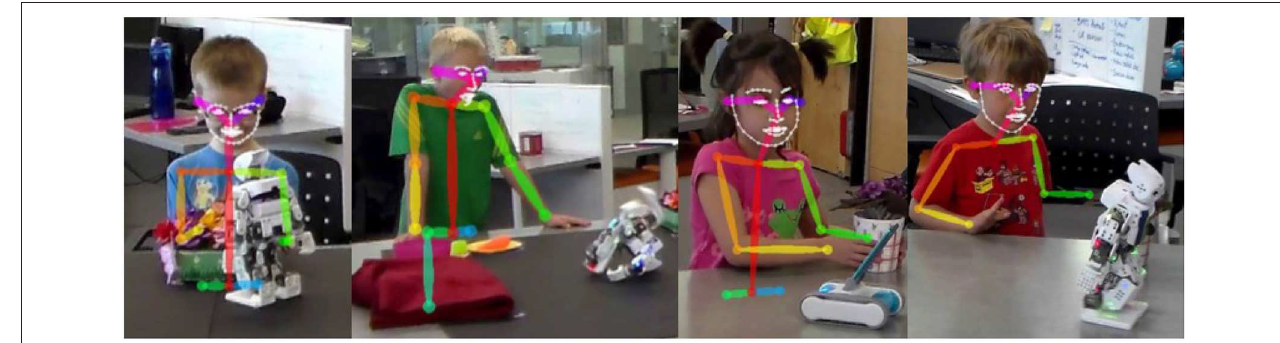
FIGURE 3 | Upper body and facial keypoints generated by